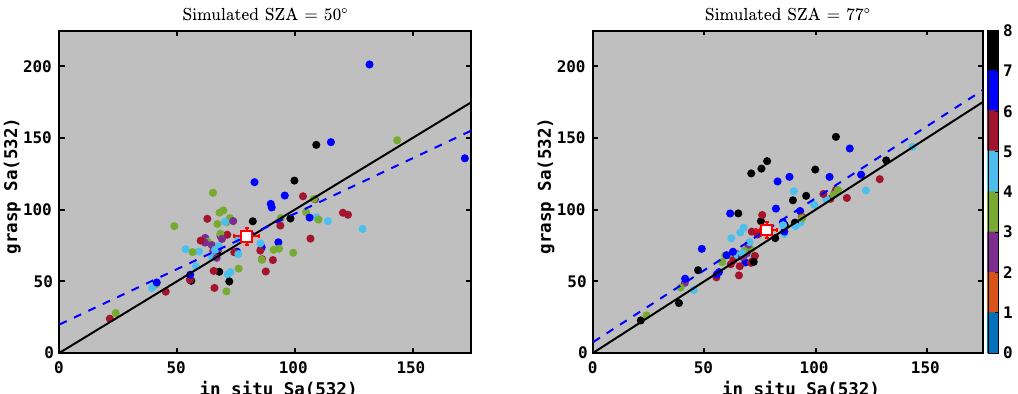
Figure 6. Comparison of bistatic LiDAR ratio derived using the GRASP phase function to bistatic LiDAR ratio derived using PI-Neph phase function, both using a bistatic scattering angle of 173 ◦ . Color code corresponds to retrieval residuals (%). Analysis in left panel uses a simulated solar zenith angle of 50 ◦ for the GRASP retrievals and the right panel uses a simulated solar zenith angle of 77 ◦ . Solid lines are 1:1, dashed lines are linear regressions, and red squares are the mean of both methods; error bars represent two standard deviations of the mean. Regression statistics are provided in Table 3. Table 3. Linear regression statistics for bistatic LiDAR ratio at a backscatter angle of 173 o and a wavelength of 532 nm, effective radius, average radius, effective variance, average standard deviation, and integrated volume of the size distributions. Analysis is restricted to retrievals with residuals of less than